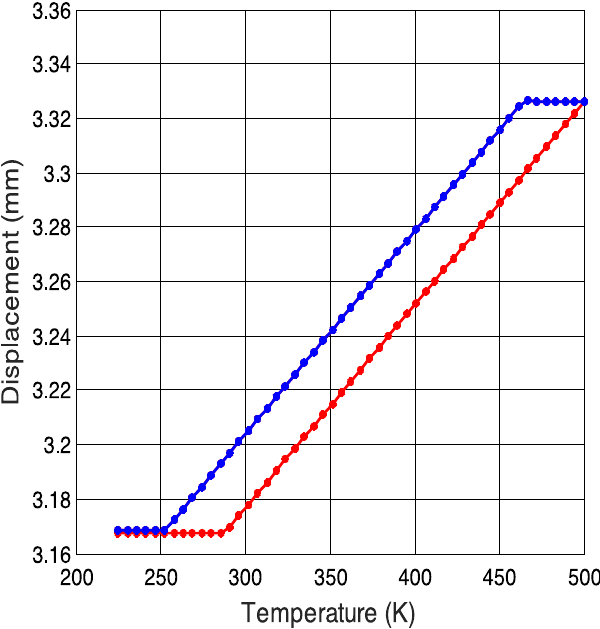
Fig. 6. Displacement as a function of heating. a: red line corresponding to heating load; b: blue line corresponding to cooling load.